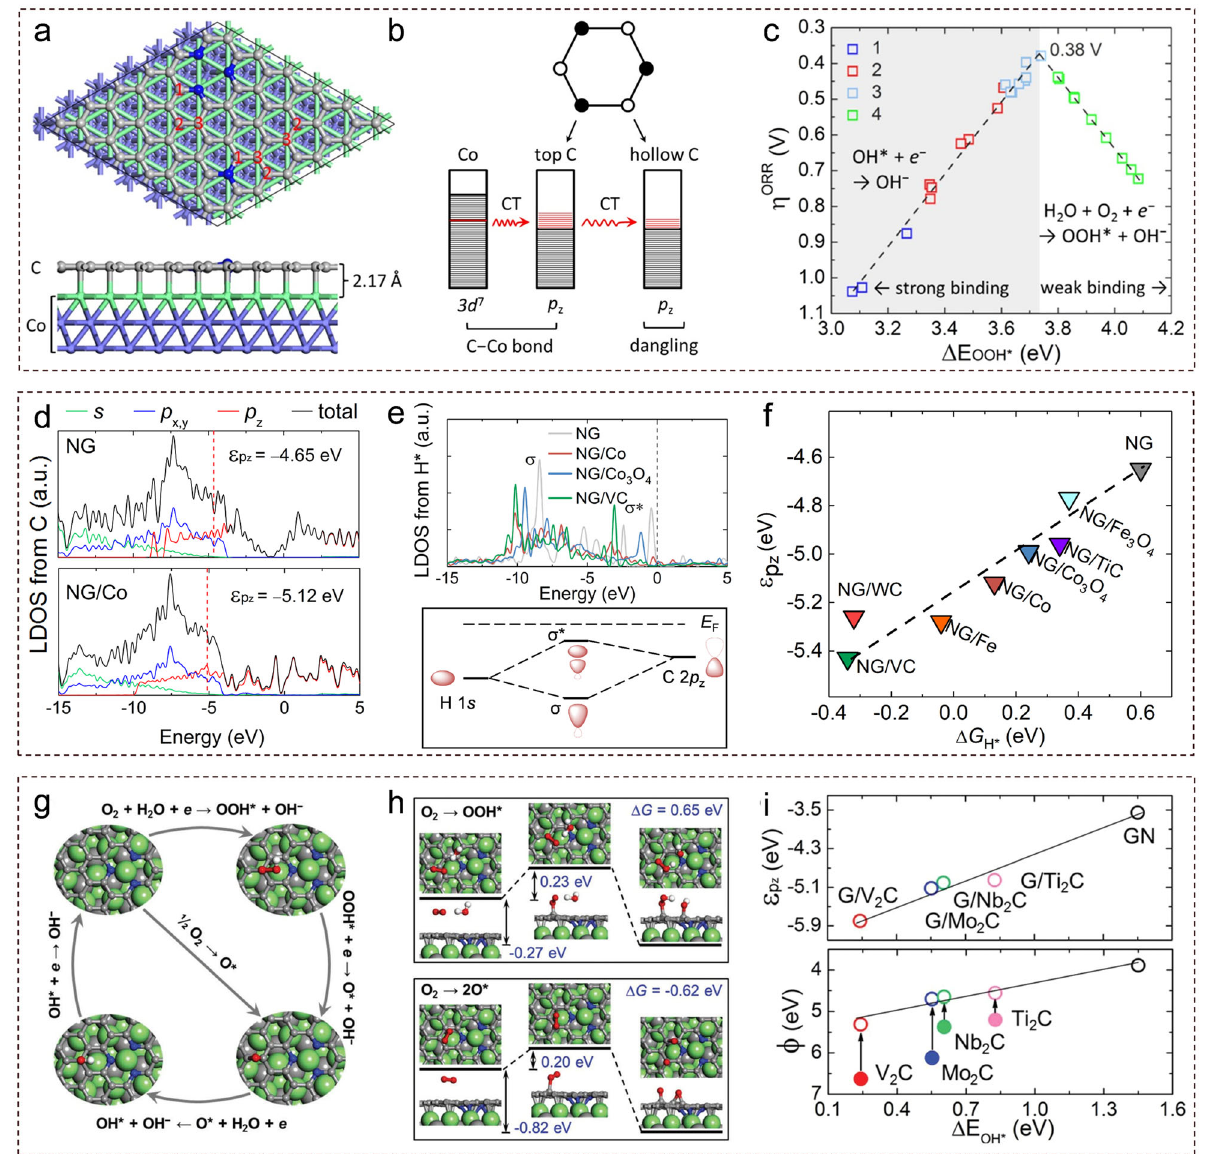
Fig. 2 Active origins of N-doped graphitic carbon/transition metal hybrid materials. a Model structures and b schematic illustration of charge transfer of N-doped graphene (NG) on Co(111) substrate. c Volcano plots of ORR overpotential vs binding energy of OOH* on various sites of NG on Fe(110) substrate in alkaline media ( a – c are reproduced with permission from ref. 90 , Copyright © American Chemical Society 2017). d Local density of states (LDOS) of C atoms in freestanding NG, and the NG/Co hybrid system. e LDOS of a H atom adsorbed on the most active site of NG and the NG/metal hybrid system (upper panel). Schematic illustration of formation of H – C bonds for the NG/metal hybrid system (bottom panel). f The C p z band center as a function of the lowest Δ G H* value ( d – f are reproduced with permission from ref. 93